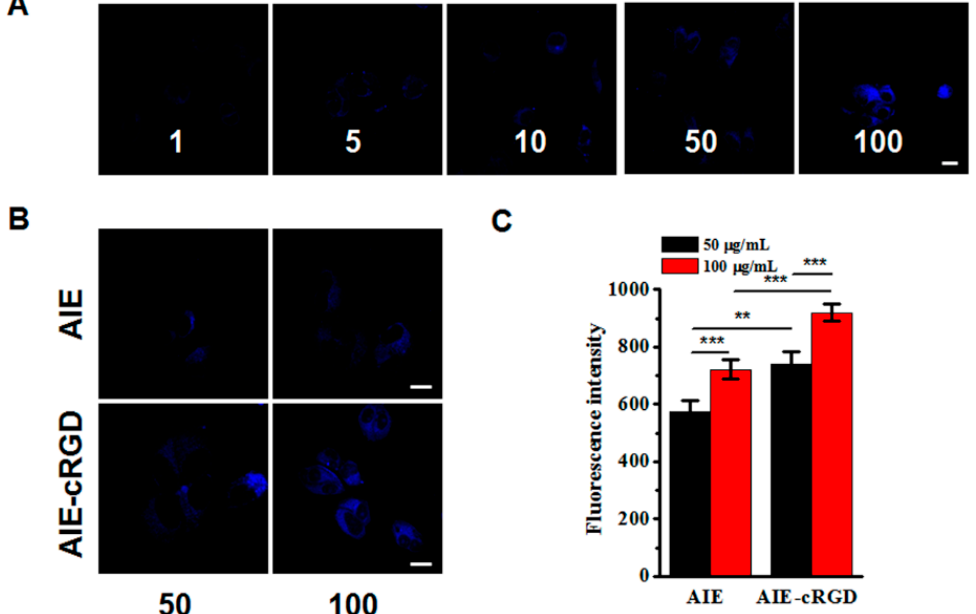
Figure 3. Concentration of probe for labeling the living cells. ( A ) Confocal images of MDA-MB-231 cells after incubation with different concentrations AIE–cRGD (1, 5, 10, 50, 100 μ g/mL, in PBS) at 4 °C overnight. ( B ) Confocal images of MDA-MB-231 cells. Incubated with AIE and AIE–cRGD with different concentrations (50 μ g/mL, 100 μ g/mL μ g/mL), respectively. ( C ) MDA-MB-231 cells fluorescence intensity statistical data. The cells were incubated with AIE and AIE–cRGD (50 μ g/mL, 100 μ g/mL) at 4 °C overnight, respectively. *** p < 0.001, ** p < 0.01, represented significant differences compared with the control group. Bar = 20 μ m.